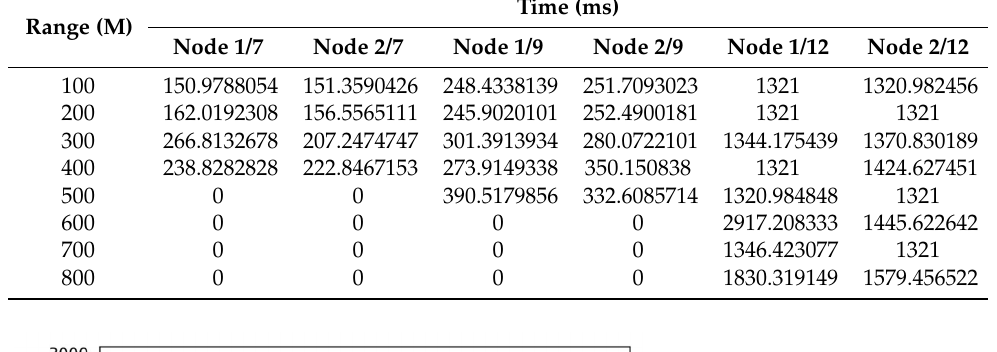
Table 3. Assessment of several spreading factor parameters.